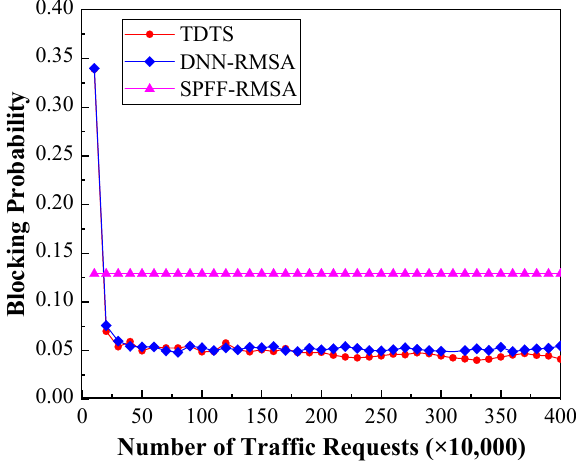
Figure 9. Blocking probability of TDTS, DNN-RMSA, and SPFF-RMSA.